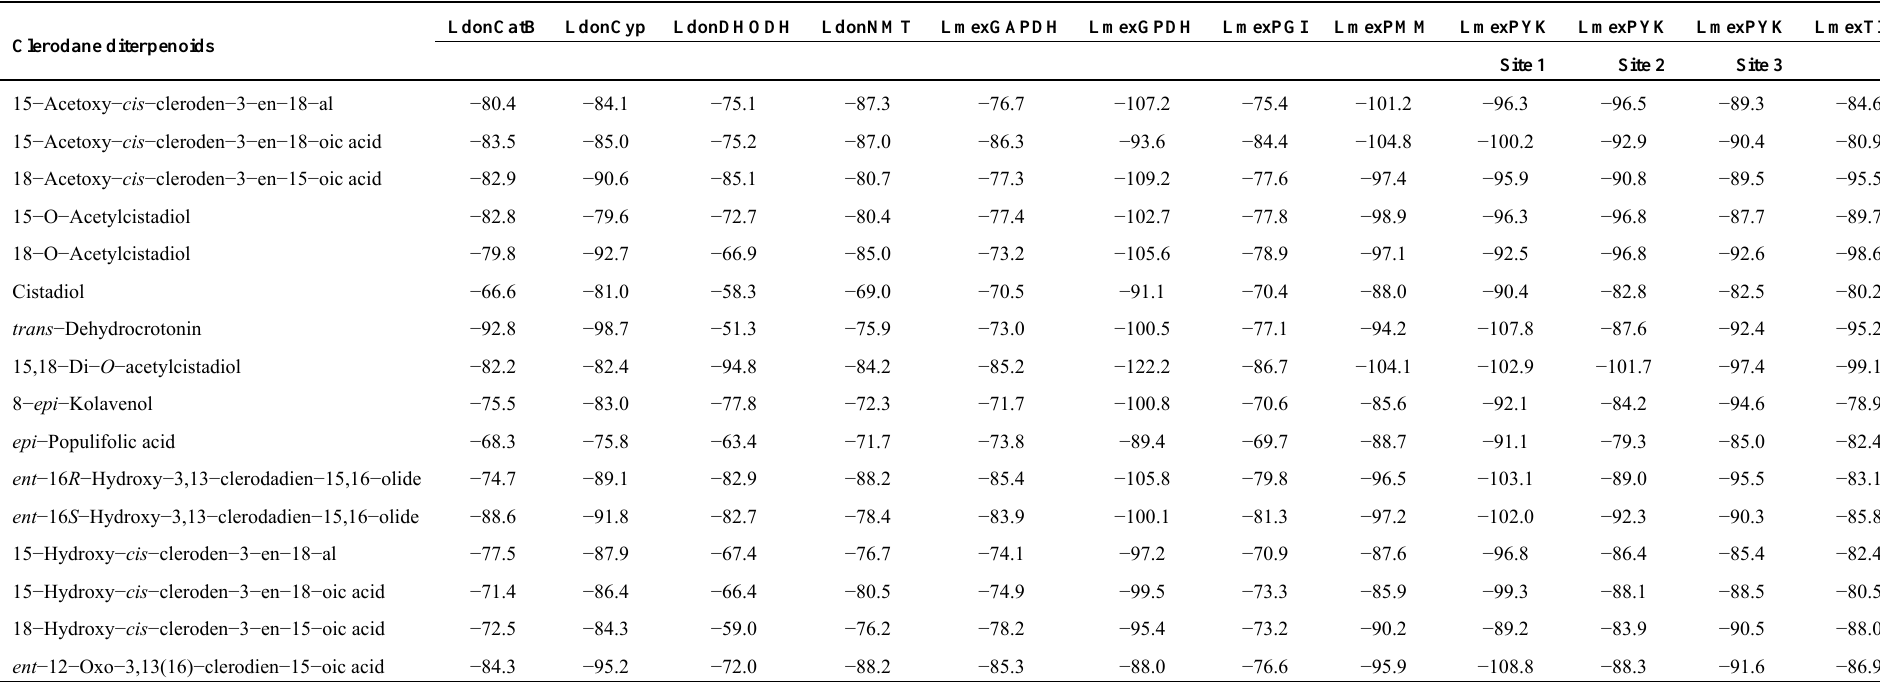
Table 20. MolDock docking energies (kJ/mol) of clerodane diterpenoids with Leishmania donovani and L. mexicana protein targets. Clerodane diterpenoids